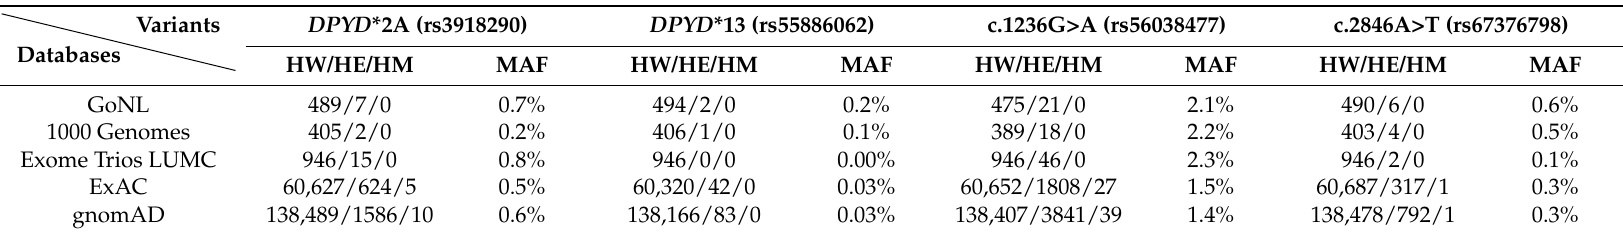
Table 4. MAF per database. Three databases (GoNL, 1000 Genomes, and exome trios LUMC) containing phased data were checked for four DPYD variants. Two large online databases (ExAC and gnomAD) were checked to identify the MAFs of the individual DPYD variants. For each DPYD variant, the genotype distribution and MAF are shown. Abbreviations: MAF: minor allele frequency; HW: homozygous wild-type; HE: heterozygous carrier; HM: homozygous carrier; GoNL: Genome of